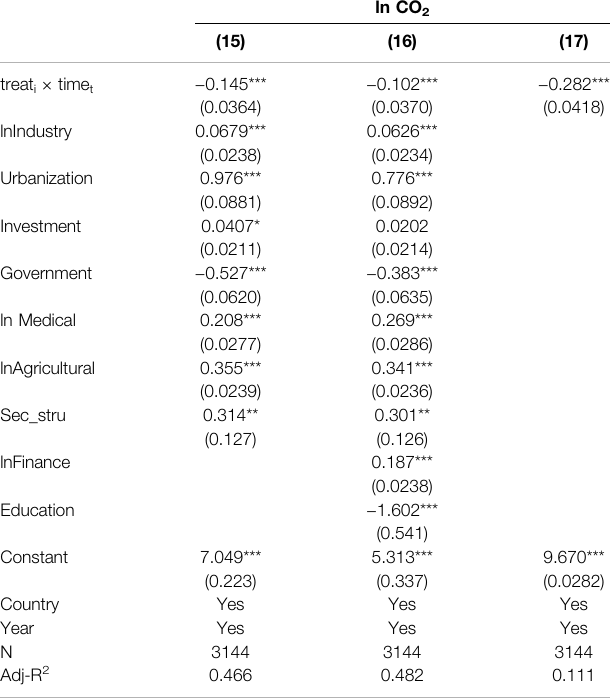
TABLE 6 | Role of forest resource protection on carbon emissions.